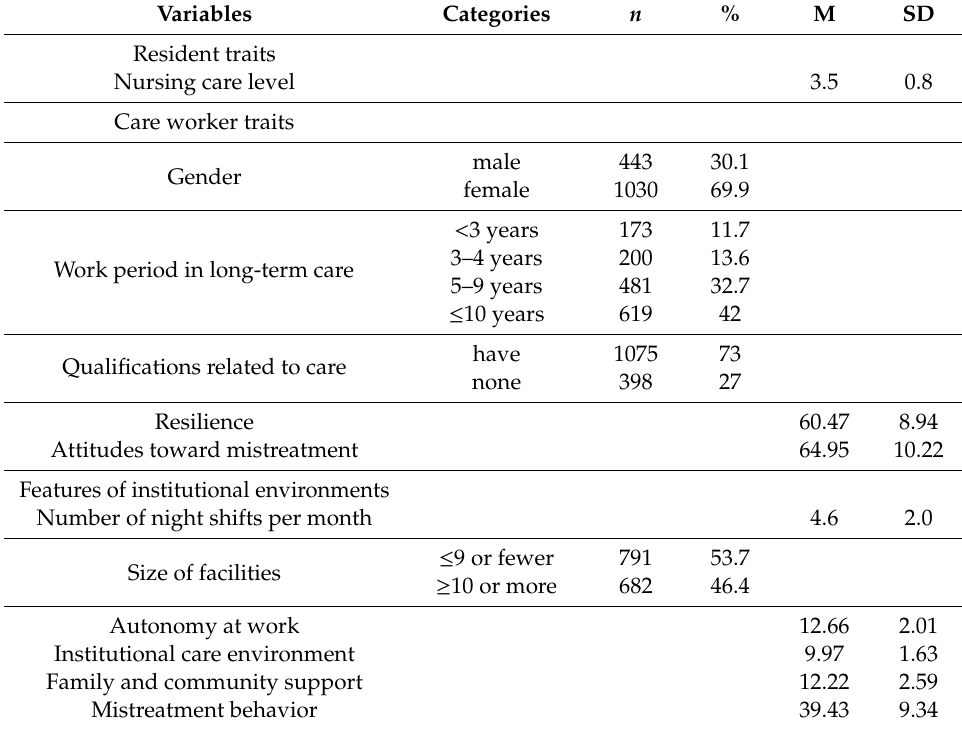
Table 2. Characteristics of the